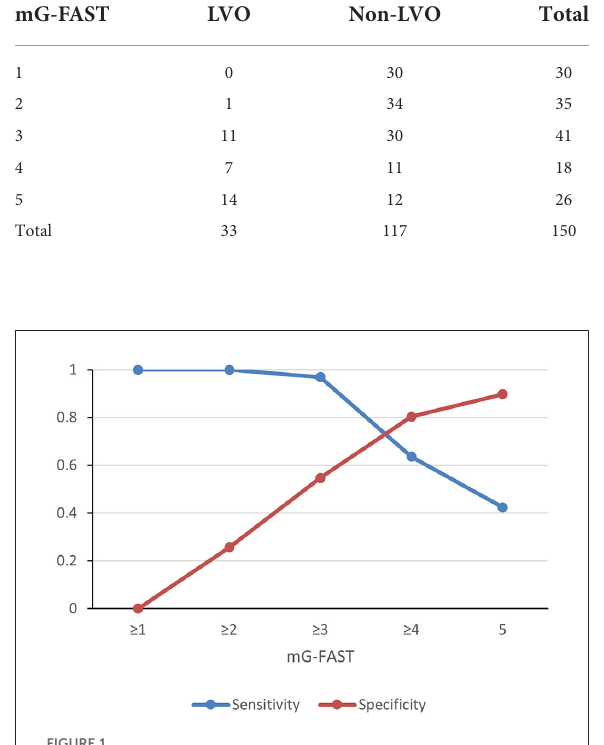
FIGURE1 Sensitivity and specificity of different cutoff points of mG-FAST for detection of large vessel occlusion